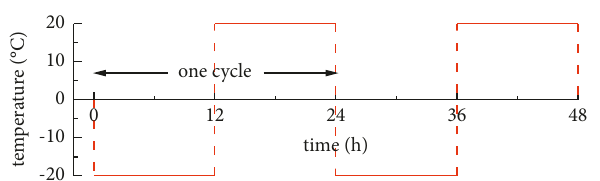
Figure 2: F-T cycle